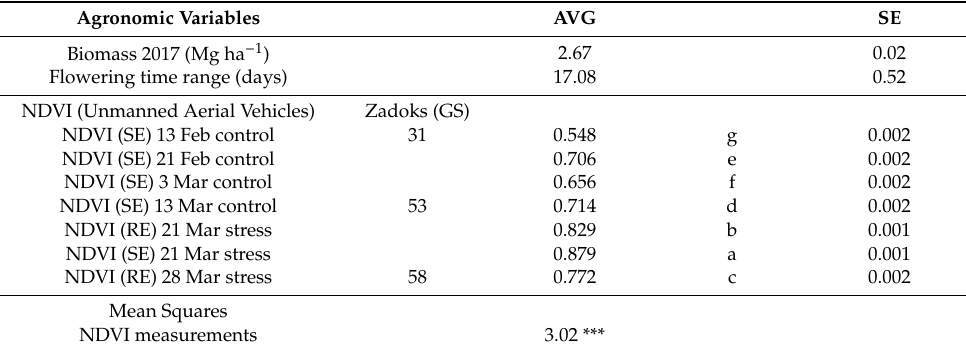
Table 1. Average (AVG) and standard error (SE) for dry biomass, nitrogen biomass, flowering time range (di ff erence between extreme genotypes), and the Normalized Di ff erence Vegetation Index (NDVI). This index was assessed using Sequoia (SE) and RedEdge (RE) sensors and evaluated at di ff erent growth stages of the Zadoks scale in the 248 Elite Durum Panel (EDP) accessions. Mean values for NDVI measurements at di ff erent time points with di ff erent letter are significantly di ff erent according to the Tukey’s honestly significnt di ff erence test ( p < 0.05). The mean squares of the ANOVA for the NDVI measurement at di ff erent time points are included at the bottom of the variable. Level of significance *** p <